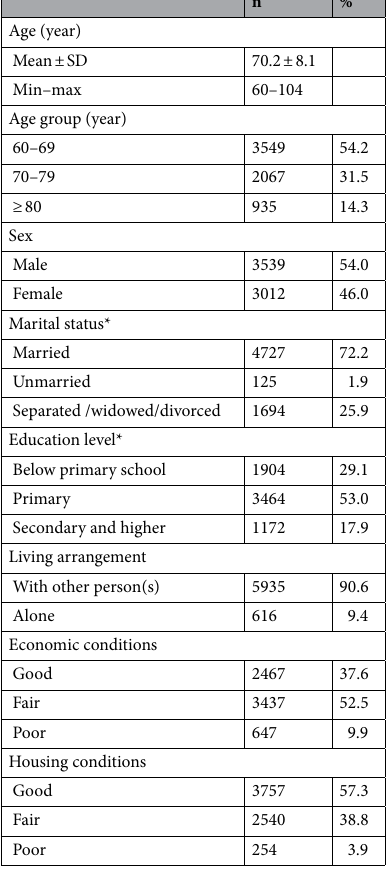
Table 1. Socio-demographic characteristics of respondents (n = 6 551). *Data of some participants were